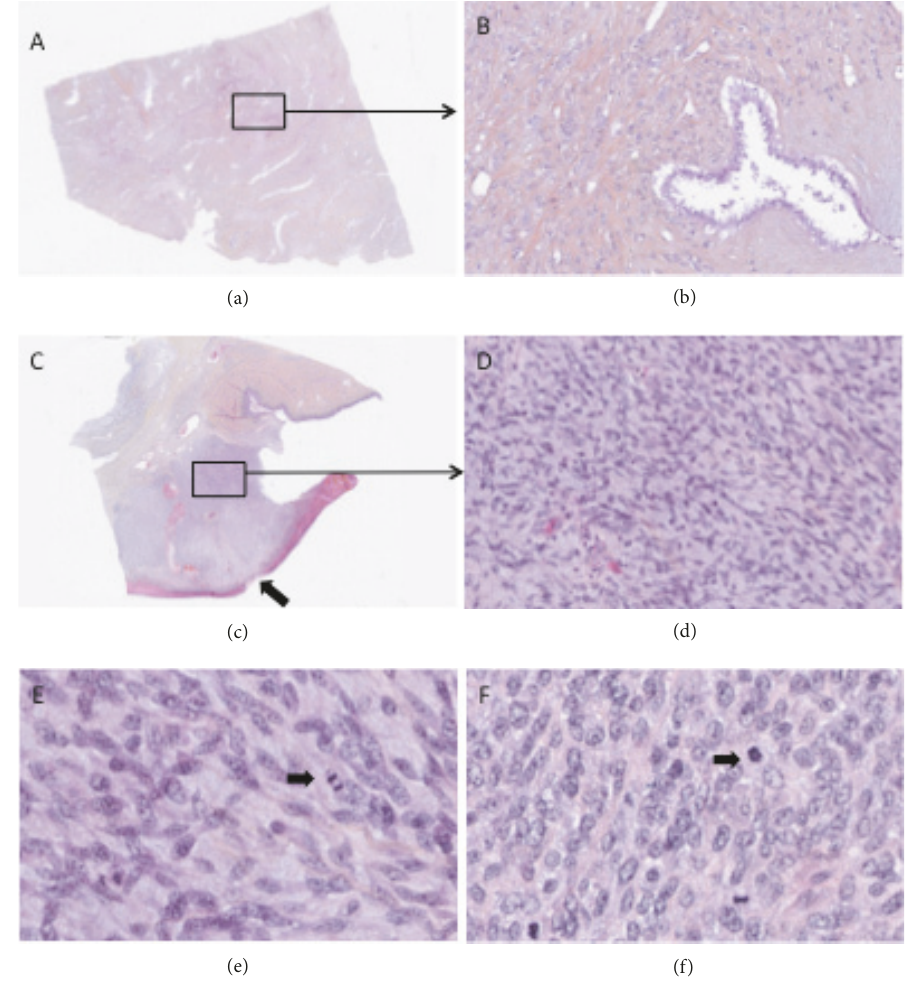
Figure 2: Microscopic aspect of the primary tumor (a, b, c, d, e) and medullar metastasis (f). (a, b) Predominant benign PT component. The stroma is more cellular than a fibroadenoma. Stromal cellularity may be higher in the zone adjacent to epithelium without atypia and mitosis ((a) magnification × 2, (b) magnification × 200), (c, d) malignant PT component observed near the cutaneous ulceration (arrow). We observed a high stromal cellularity with atypia and mitosis without epithelial structure. There was no involvement of the tissue beneath the nipples nor lymphovascular or neural invasion. ((c) magnification × 2, (d) magnification × 200), (e, f) malignant primary (e), and medullar metastasis (f) PT at magnification × 400. We observed a similar histologic pattern: a cellular stromal proliferation with atypia and mitosis (arrows). No epithelial components. All immunostainings were negative (estrogen receptor, progesterone receptor, pankeratin AE1, AE3, and PS100, desmin, CD34, caldesmon, and CD99) except for a focal staining with Smooth Muscle Actin